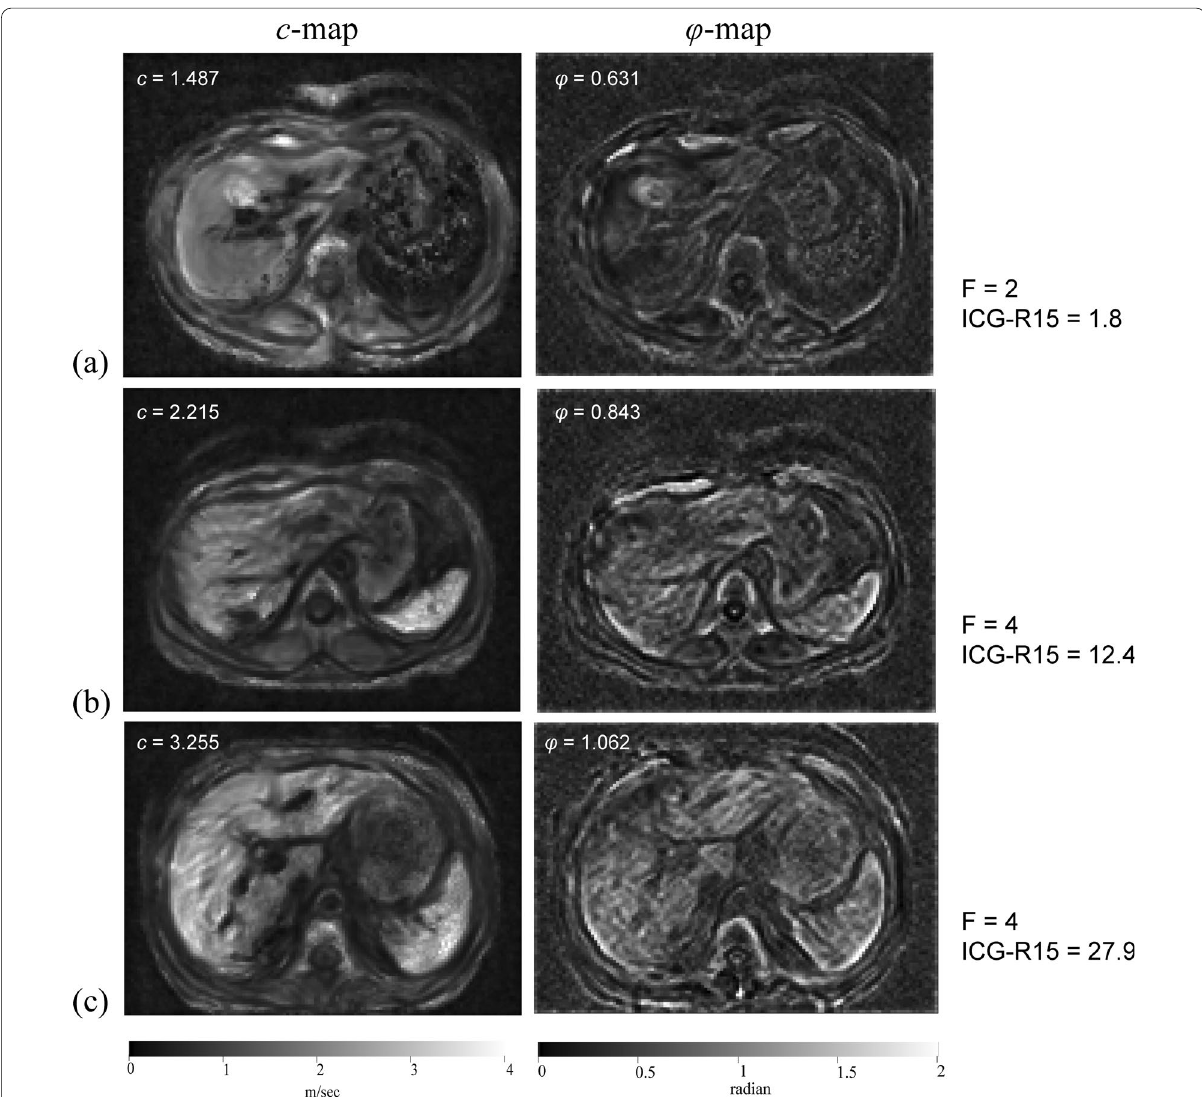
Fig. 4 Axial tomoelastography c and φ maps of the ICG-R15 data and fibrosis stages for three patients. a F 1.8; b F